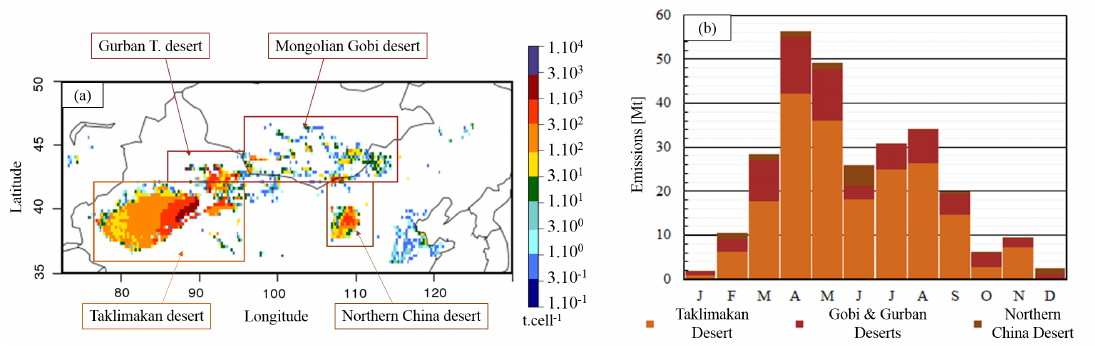
Figure 1. ( a ) Mean annual dust emissions from the main arid areas in Asia, simulated with CHIMERE for 2011, 2013 and 2015, in t cell − 1 . ( b ) Monthly emissions for the main arid areas in Mt.